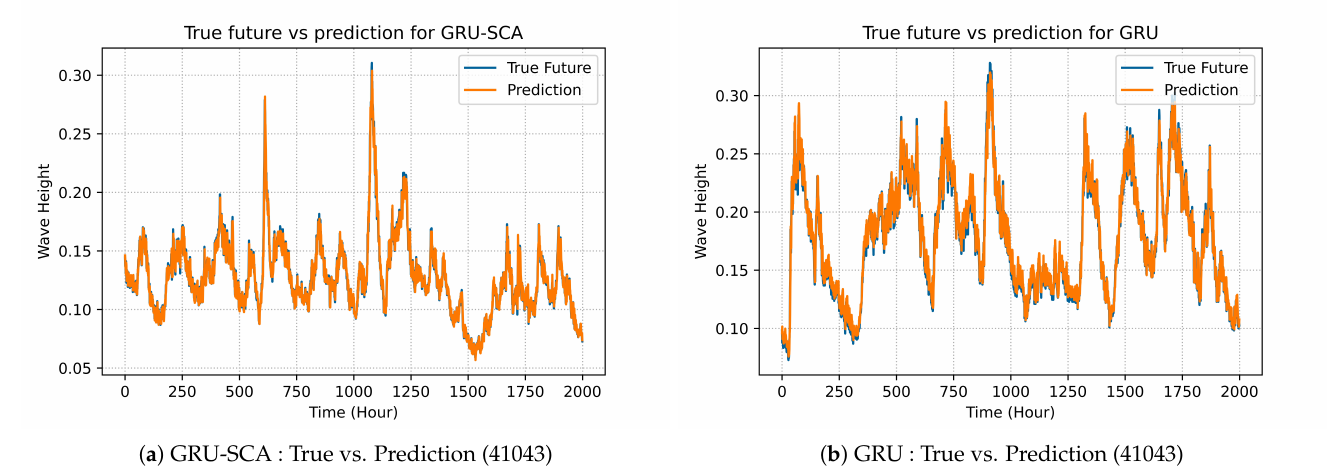
Figure 11. Comparison of GRU models on dataset 41043.